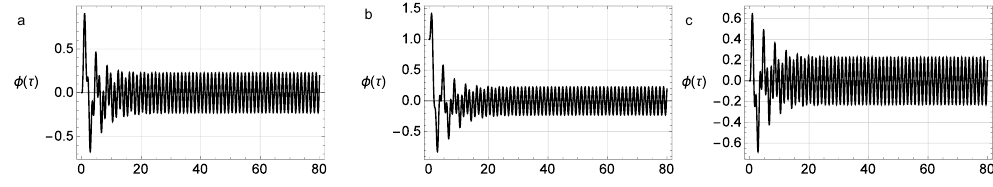
Figure 13. The dependence of the deflection angle of the pendulum, ϕ ( τ ) , on various initial conditions at ω = 1.2, H = 0.2, K = 5, Ω = 5, and σ = 1.5. Parameters of Bouc–Wen model: A = 1, β = 0.1, γ = 0.9, and n = 2. Initial conditions are different in different panels of the figure: ( a ) ϕ ( 0 ) = 0 and ˙ ϕ ( 0 ) = v ( 0 ) = z ( 0 ) = 0; ( b ) ϕ ( 0 ) = 1 and ˙ ϕ ( 0 ) = 0, z ( 0 ) = 0; ( c ) ϕ ( 0 ) = ˙ ϕ ( 0 ) = 0, v ( 0 ) = 1, and z ( 0 ) = 0.